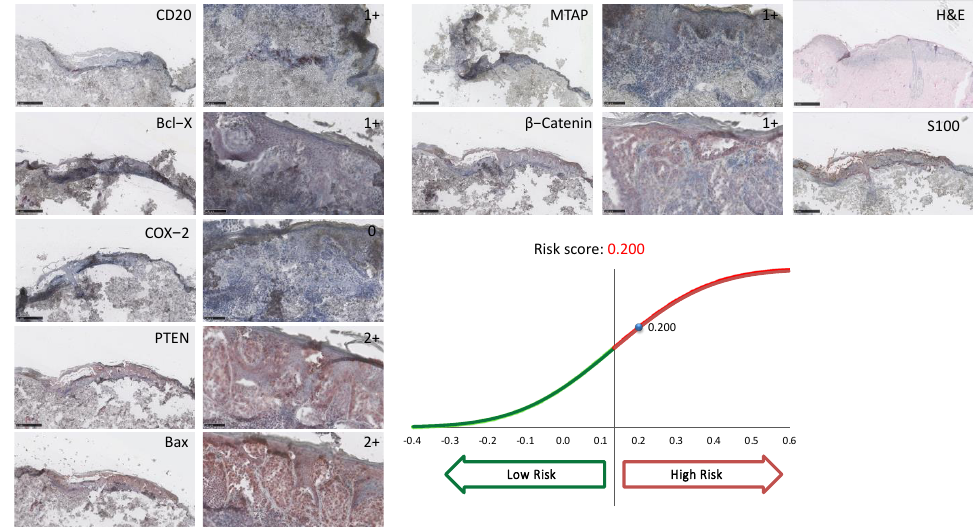
Figure 2. Immunohistochemical staining and risk score stratification Patient B. 0% of cell nuclei stained; 1+: weak cytoplasmic staining or less than 20% of cell nuclei stained; 2+: moderate cytoplas- mic staining or 21 to 50% of cell nuclei stained. COX-2 = Cyclooxygenase-2, PTEN = Phosphatase and Tensin Homolog, Bax = Bcl-2-associated X protein, MTAP = S-methyl-5 (cid:48) -thioadenosine